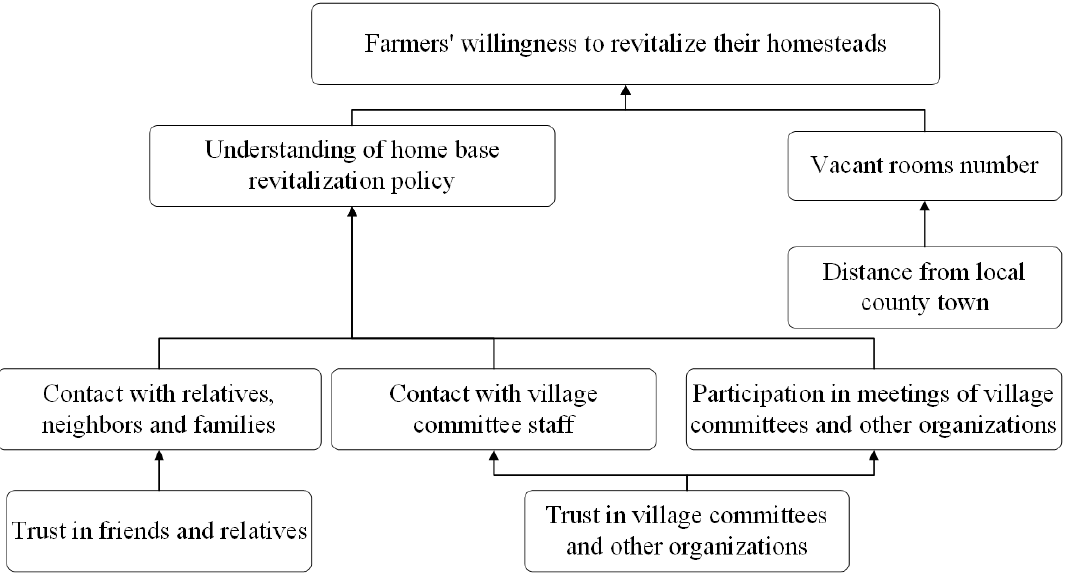
Figure 2. The hierarchical structure of factors influencing the significance of farmers’ willingness to revitalize their homesteads .